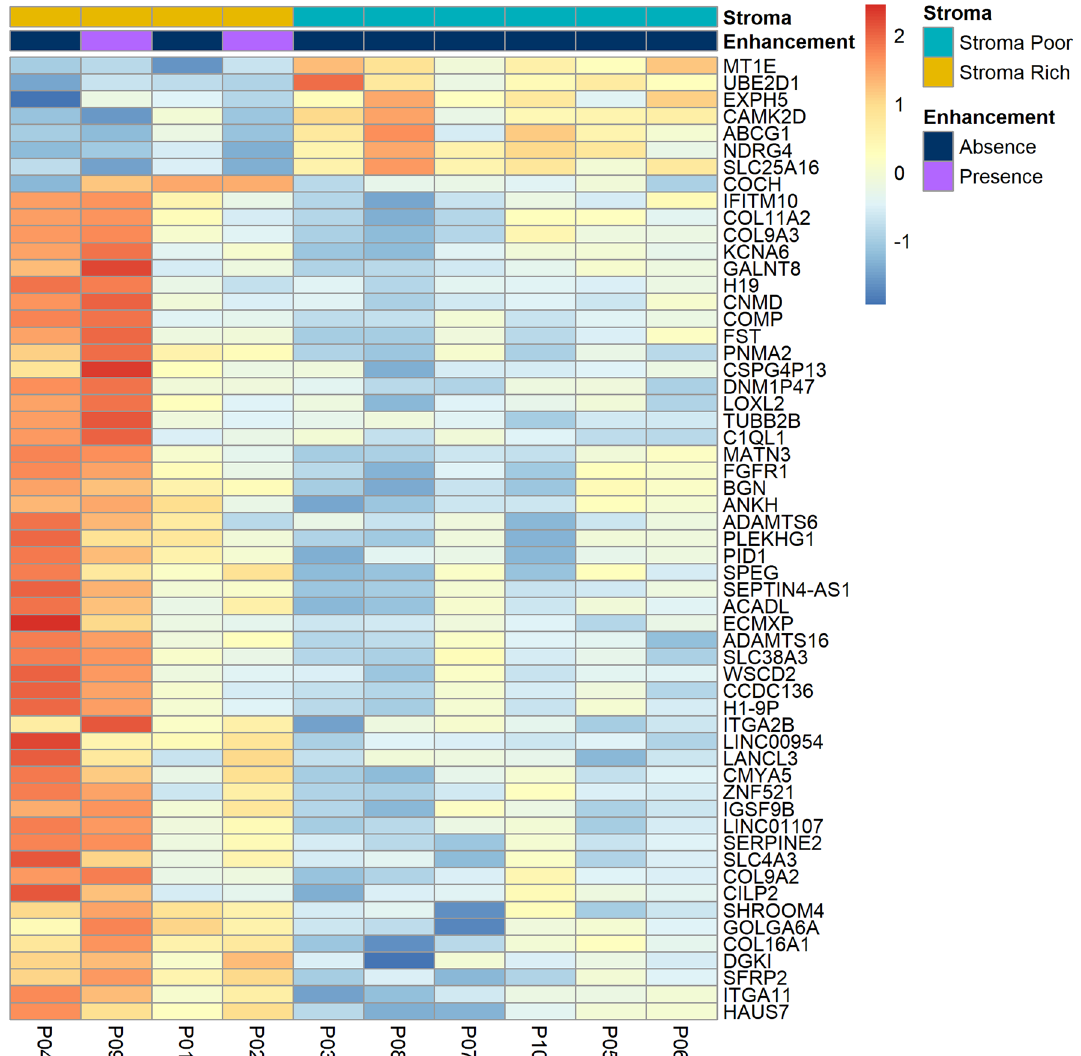
Figure 4. Heatmap view of the 10 patients with chordoma. Y-axis represents the differentially expressed genes; X-axis represents the patients with chordoma. The expression levels from low to high are represented as a color gradient from blue to red, respectively. There are two color bars of the heatmap to represent stroma status (stroma-rich and stroma-poor) and presence of enhancement on magnetic resonance imaging.